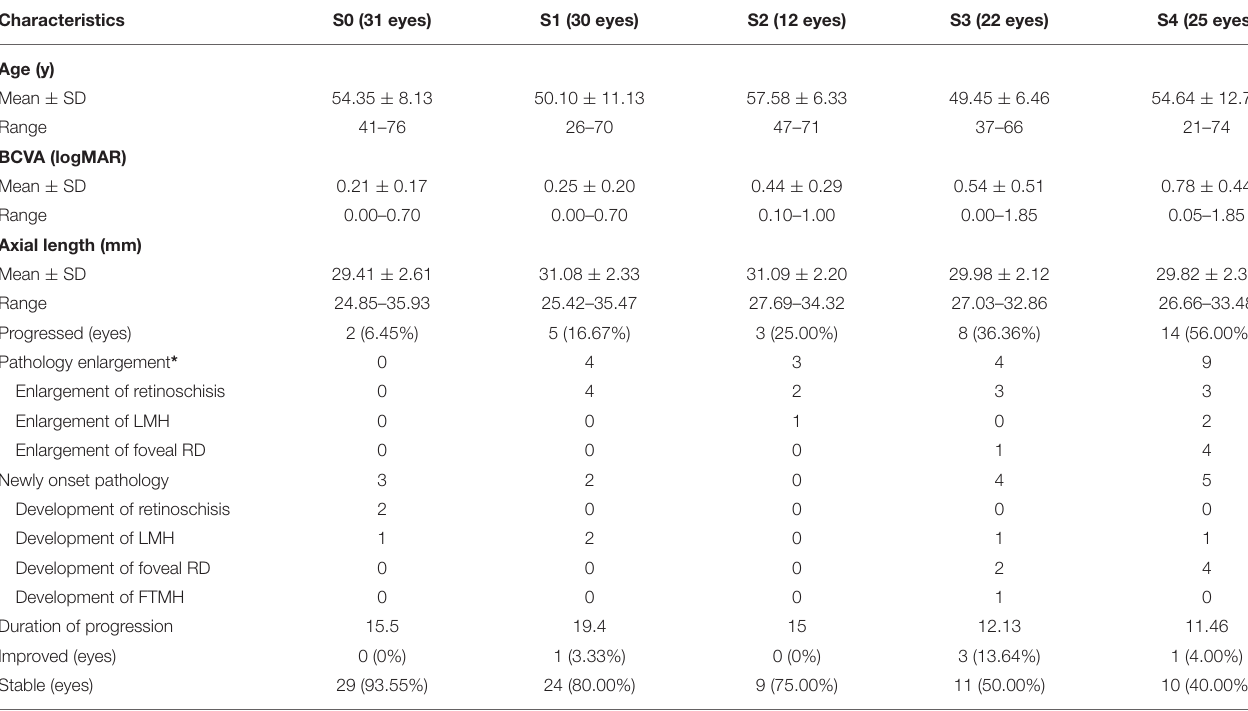
TABLE 1 | Baseline characteristics of patients with different categories of